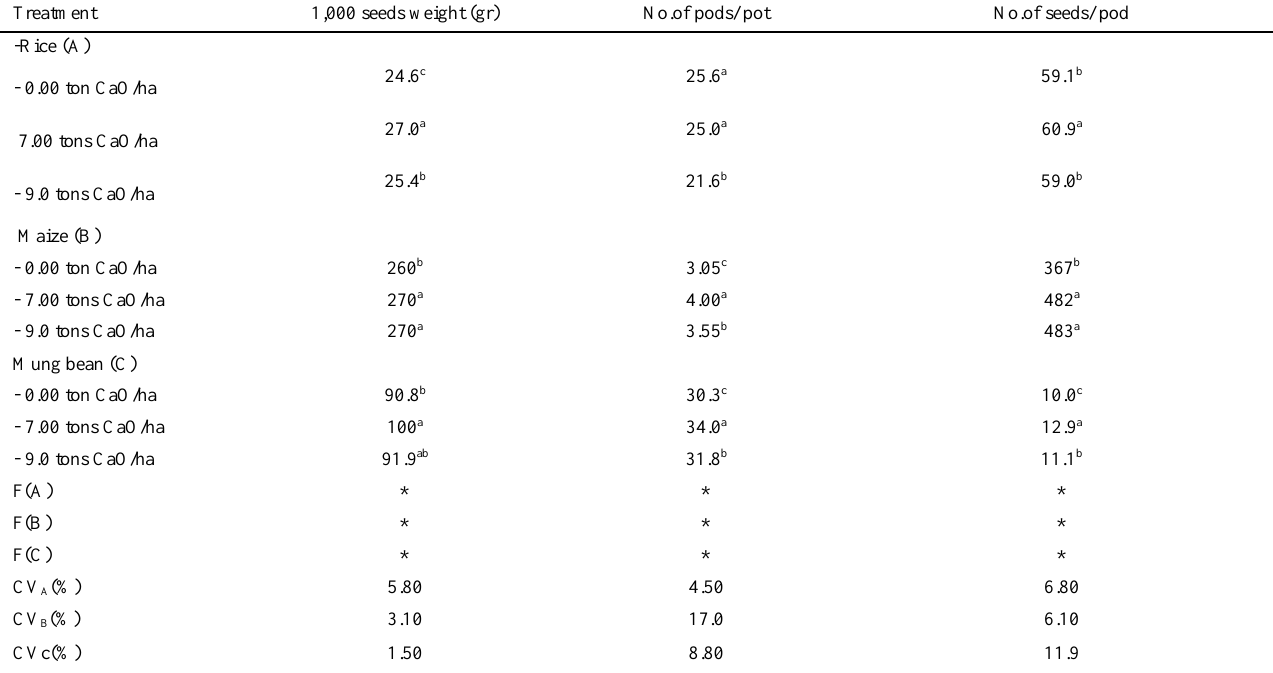
Table 7. Yield components and production of rice, maize and mung bean affected by lime ratios